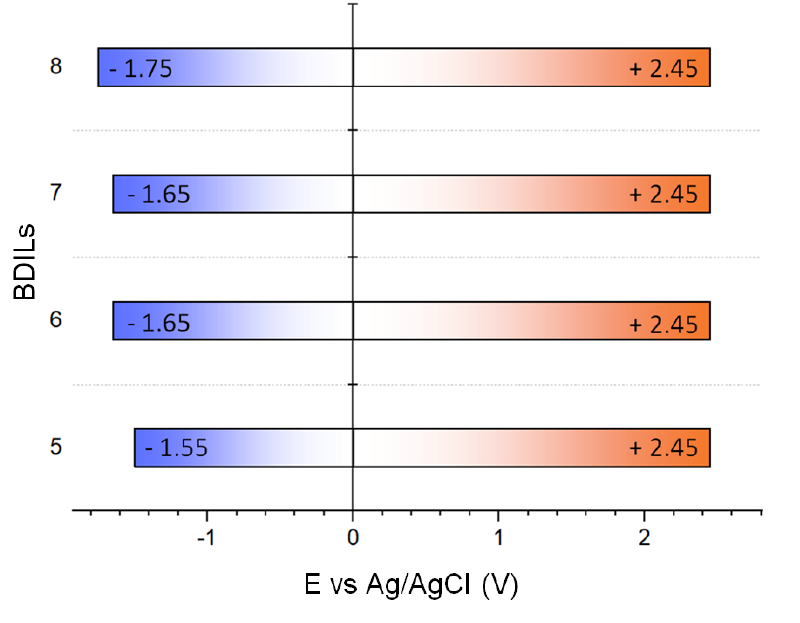
Figure 5. ECW comparison of BDILs 5 – 8 .